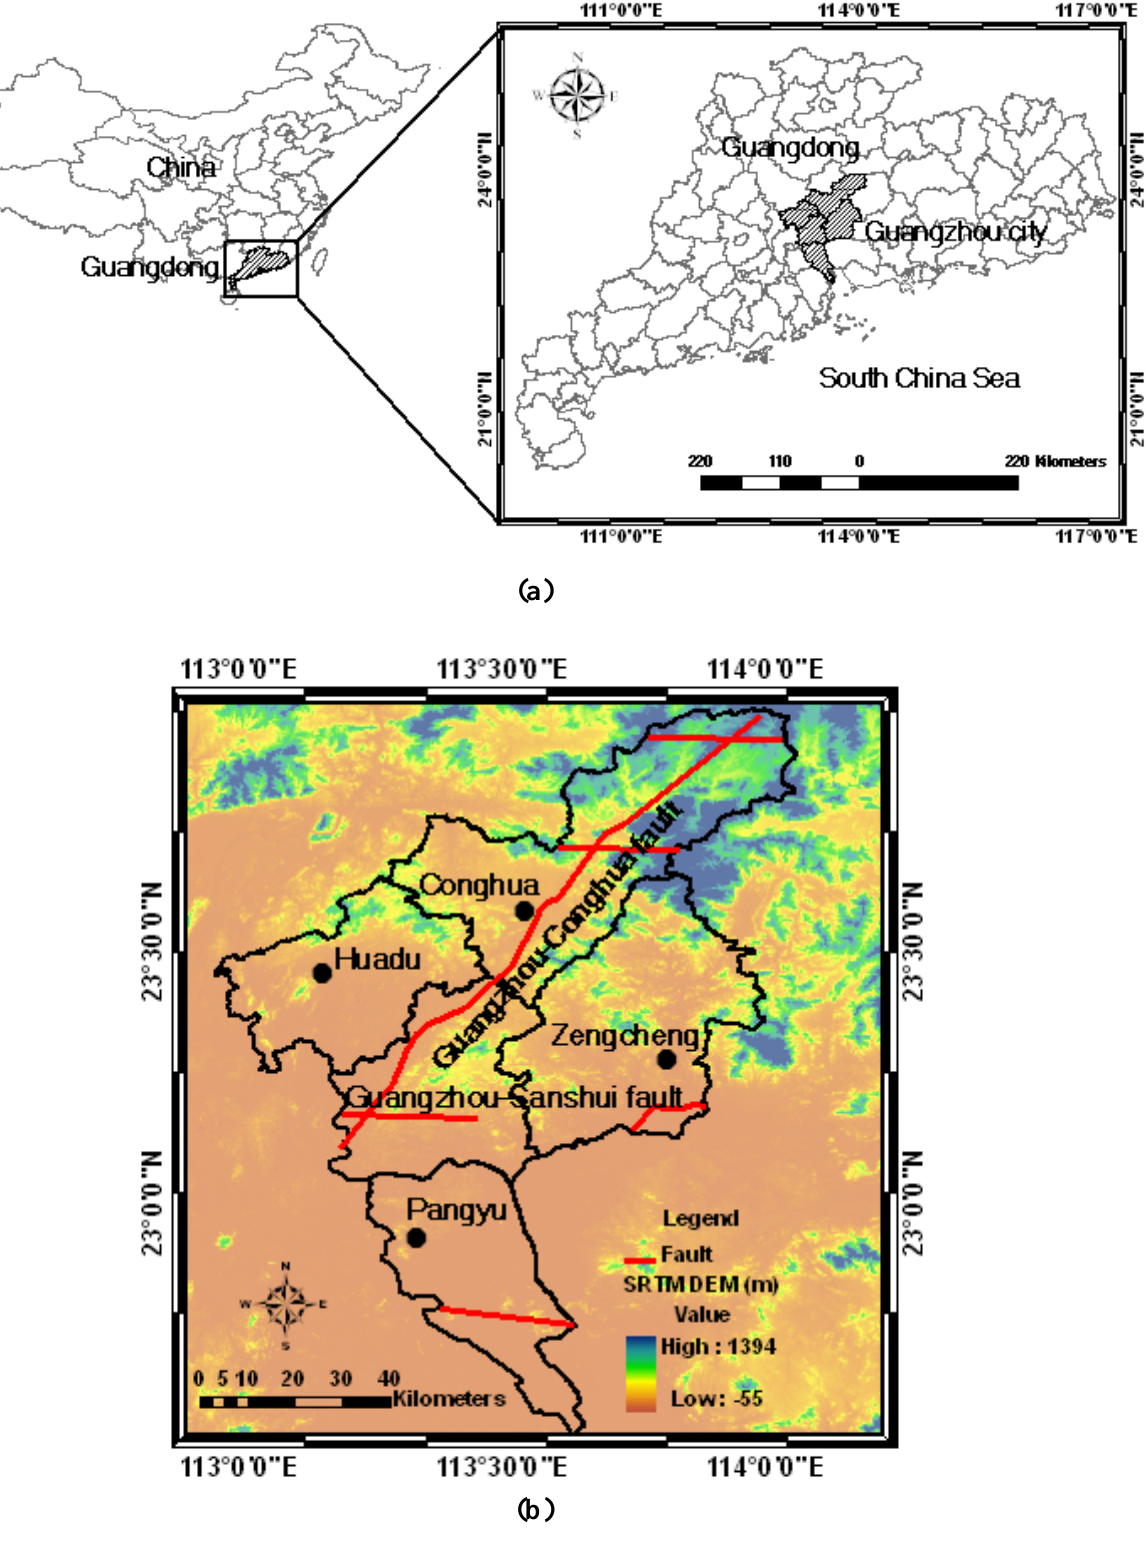
Figure 1. (a) Location of study area in Guangdong Province. (b) Map of study area. Active faults are marked in red (partially referred to [5,